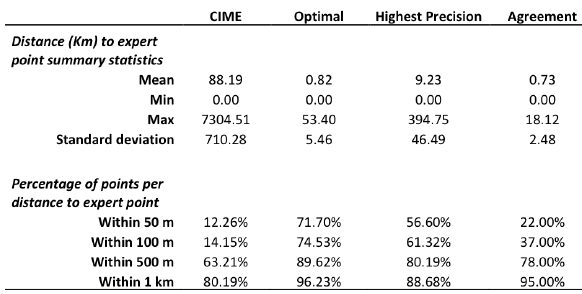
Figure 16. Level of precision achieved with highest precision aggregation